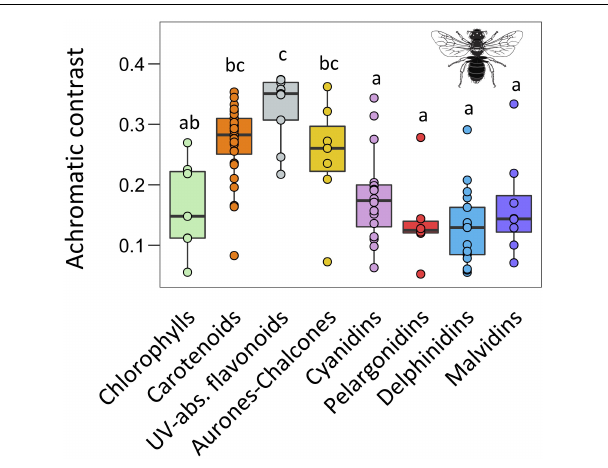
FIGURE 4 | Boxplots representing the distribution of achromatic contrast values for each type of pigment calculated in the hexagonal colour model for bee vision. The central line displays the median, the bottom and top of the box are the first and third quartiles, and dots represent sample values. We performed phylANOVAs with 10,000 simulations and Holm-adjusted P -value. Different letters represent significant differences at 0.05 level. Bee silhouette taken from Divulgare (www.divulgare.net) under a Creative Common